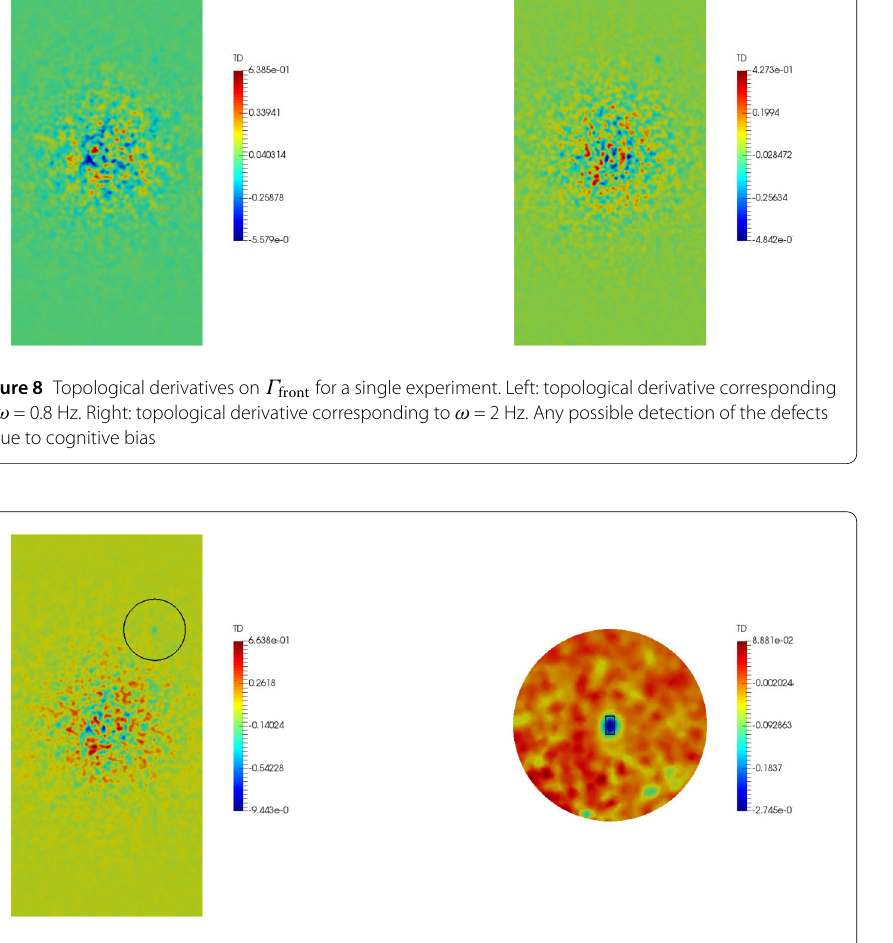
Figure 9 Topological derivative on Γ front for two combined frequencies. Left: topological derivative combining single-frequency data at 0.8 and 2 Hz. Right: zoom of the previous image around the box-shaped defect with the colormap rescaled to the visible range. The outline of the defect is also shown in black on the image on the